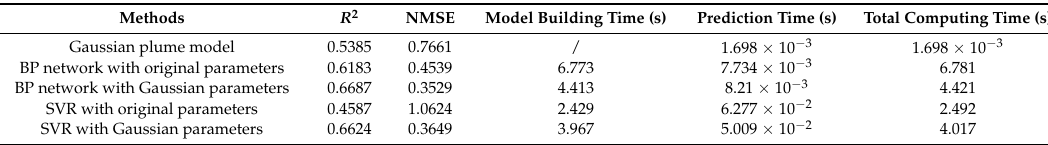
Table 2. Prediction performances of proposed machine learning (ML) models on the Prairie Grass test set.